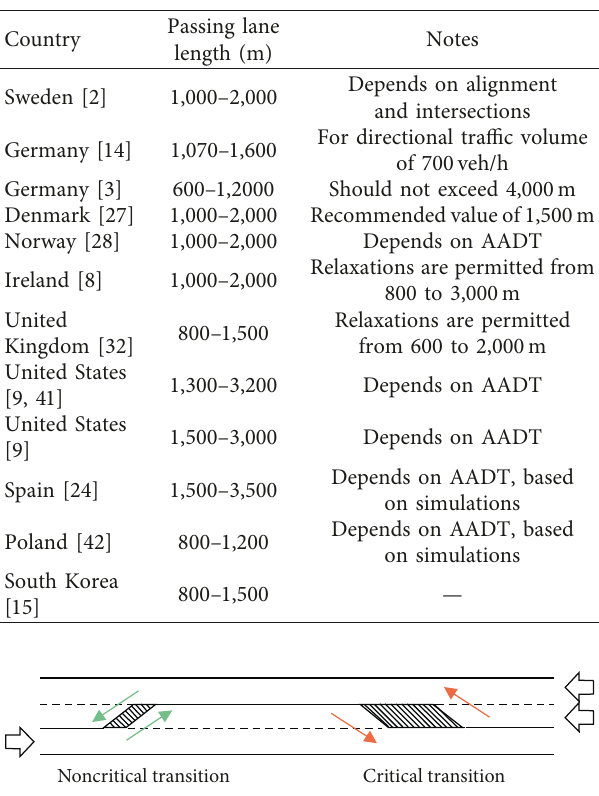
Table 3: Comparison of international passing lane lengths for 2+1 highways.